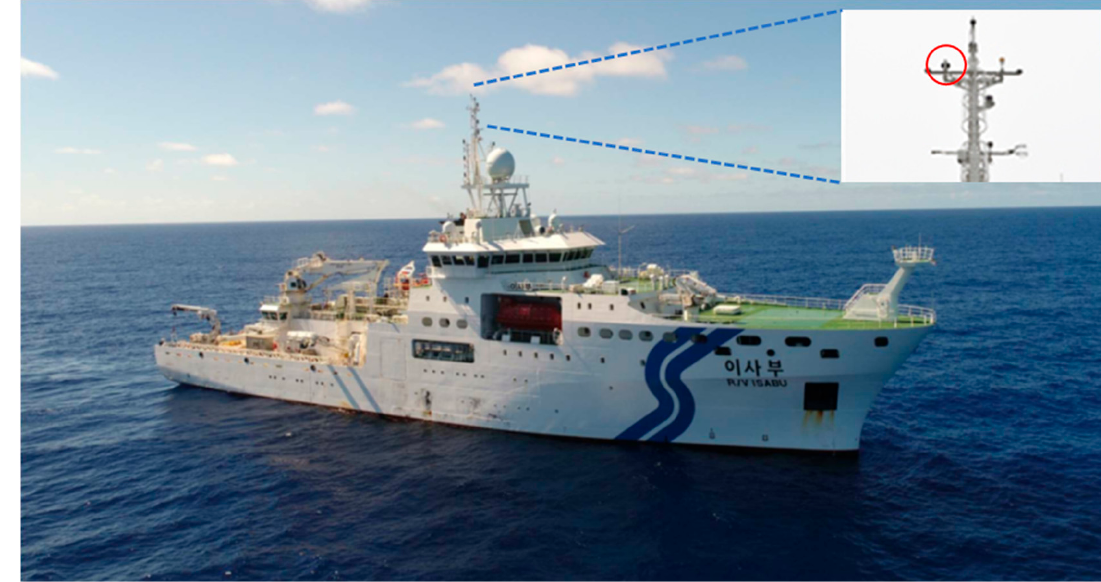
Figure 1. The Global Navigation Satellite System (GNSS) antenna (red circle) installed on the mast of the research vessel ISABU.